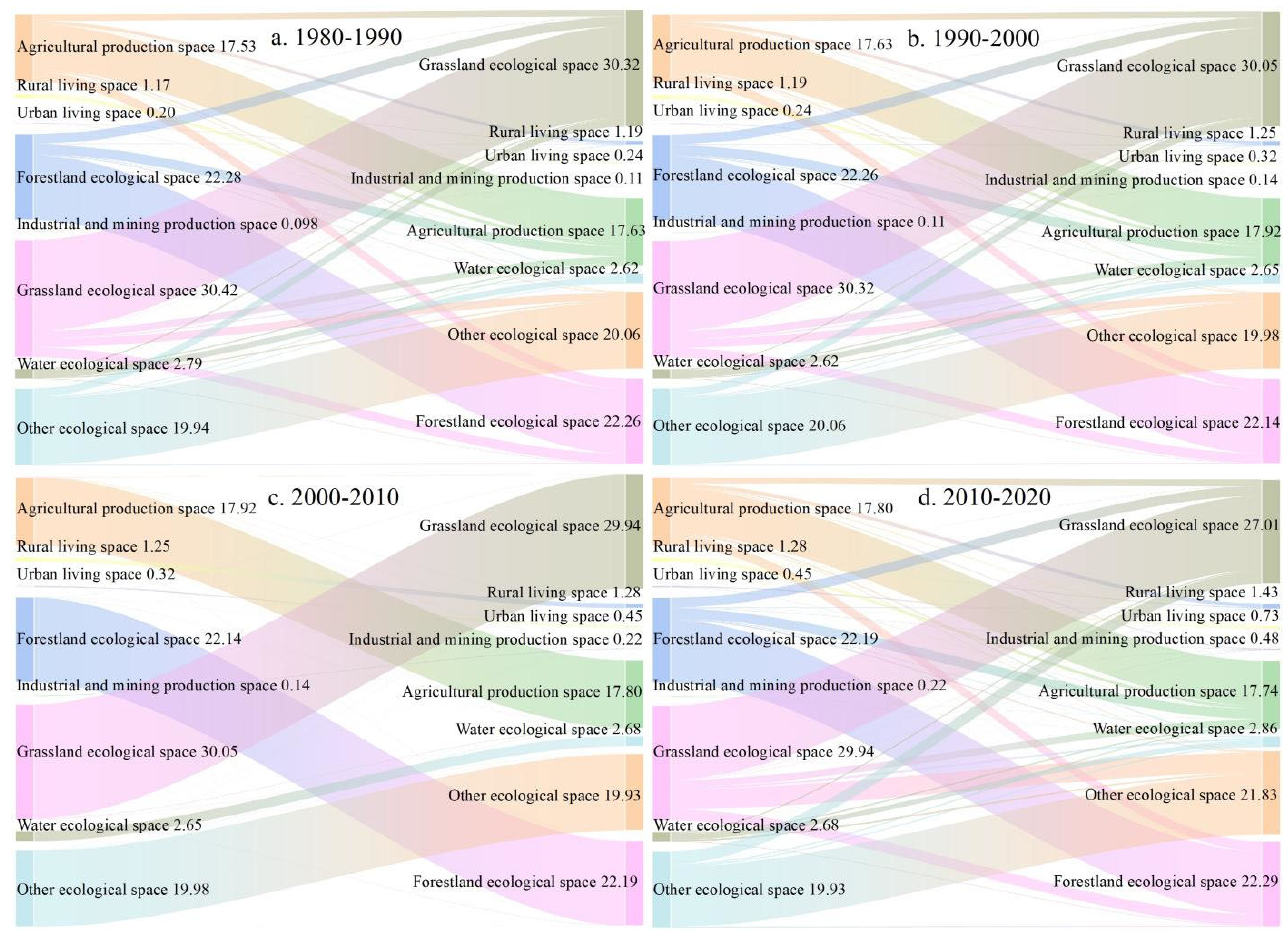
Figure 6. Sankey diagram of territorial space transfer matrix (Unit: 10 5 km 2 ). From 2000 to 2010, grassland ecological space turned into agricultural production space, agricultural production space turned into urban living space, and grassland ecological space turned into forestland ecological space, accounting for 11.94%, 9.51%, and 7.94% of the transformation area of territorial space from 2000 to 2010, respectively. From 2010 to 2020, the transition between other ecological space and grassland ecological space was the most intense, accounting for 28.73% of the national spatial transformation area from 2010 to 2020, followed by grassland ecological space to forestland ecological space, accounting for 9.73% of the national spatial transformation area. From 2010 to 2020, the area of grassland ecological space converted to other space was 1,066,650.67 km 2 , followed by the agricultural production space converted to other space, reaching 607,092.58 km 2 . From 2010 to 2020, the area of other space converted to grassland ecological space was the largest, reaching 7,760,669.25 km 2 , followed by other space to other ecological space and agricultural production space, 615,643.26 km 2 and 603,473.00 km 2 ,